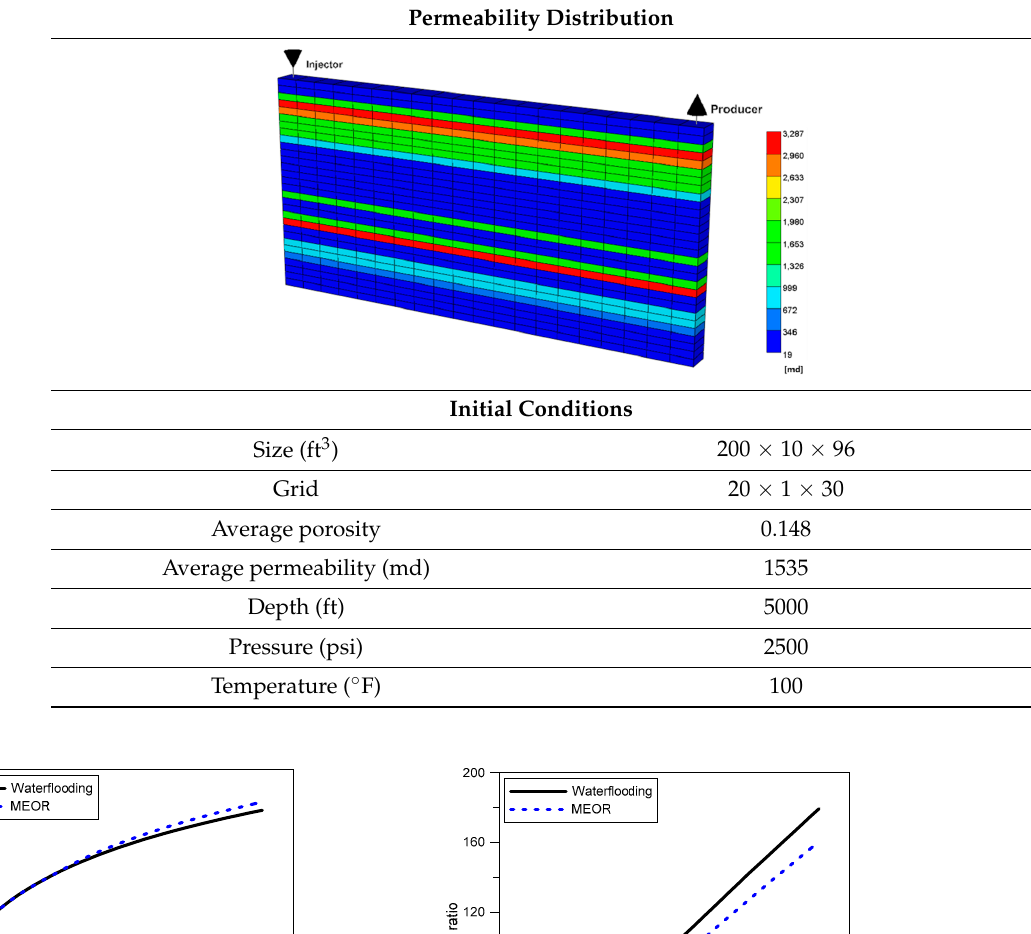
Table 3. Initial conditions of the King Island reservoir.